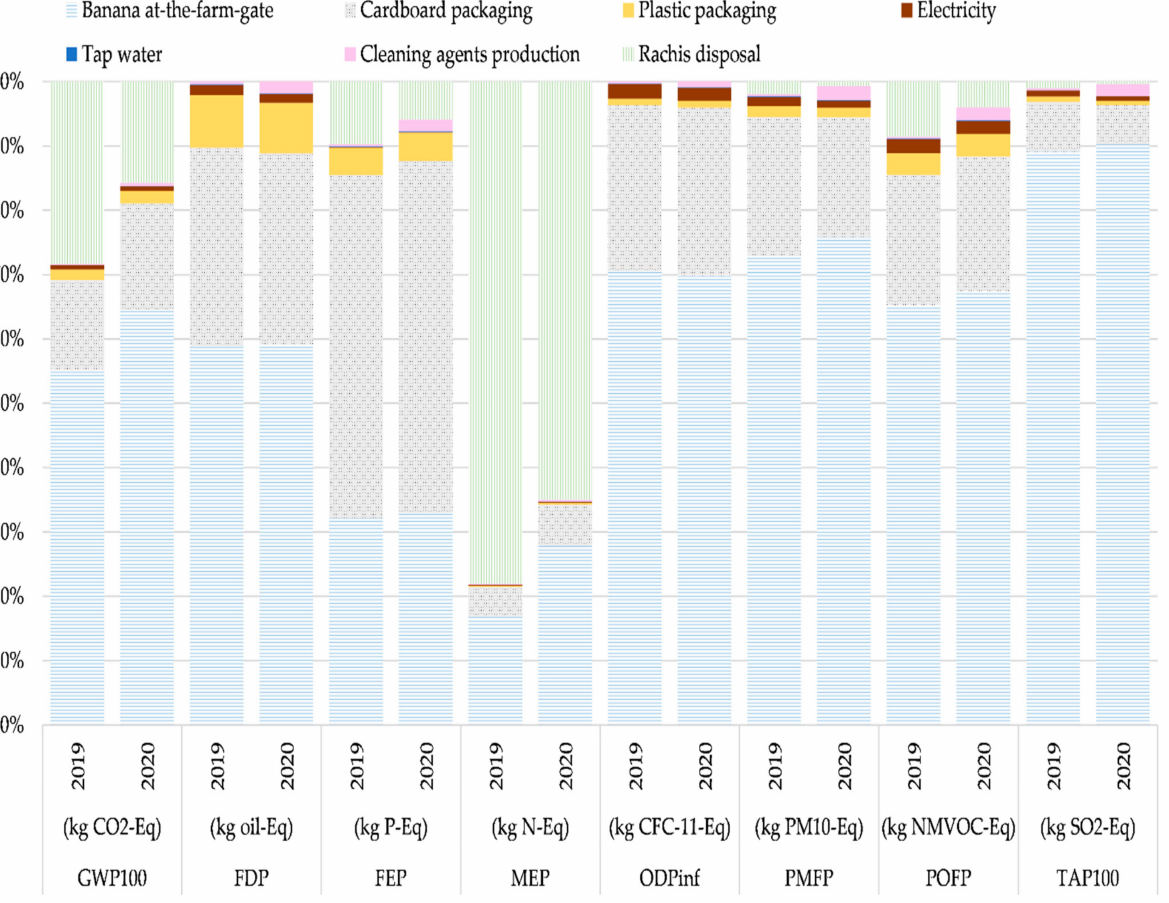
Figure 3. Contribution analysis of processes for the flow of “Banana at-the-packaging-stage-gate”, classified by impact category for the periods 2019 and